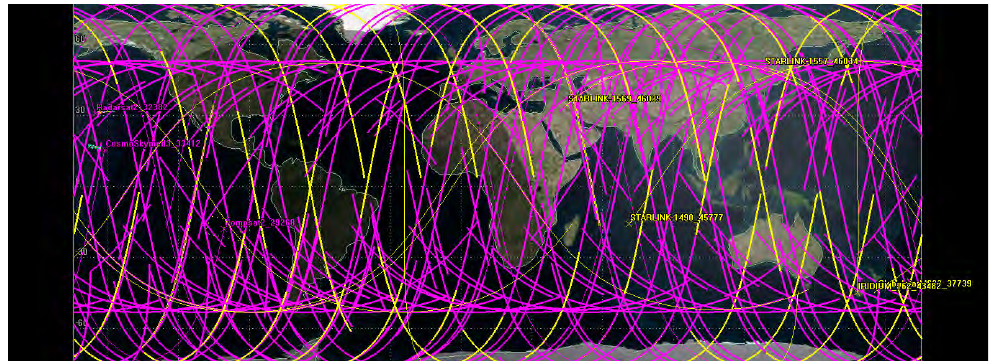
Figure 7. Spatial information network computing environment simulation platforms. ( a ) Satellite management. ( b ) Observation scene.